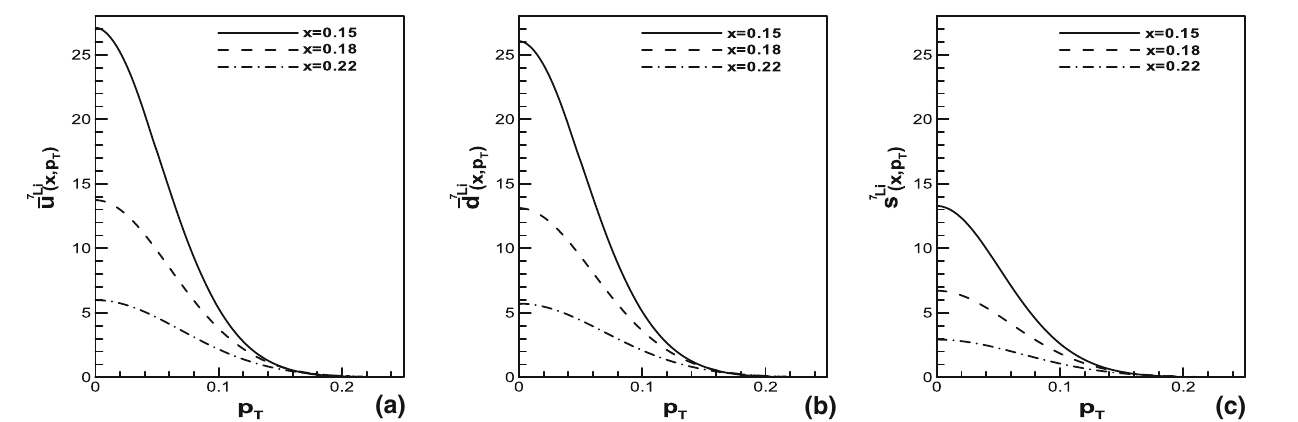
Fig. 7 The sea quak p T -distributions of 3 He , a ¯ u , b ¯ d and c s , at x = 0 . 15 , 0 . 18 and 0 . 22